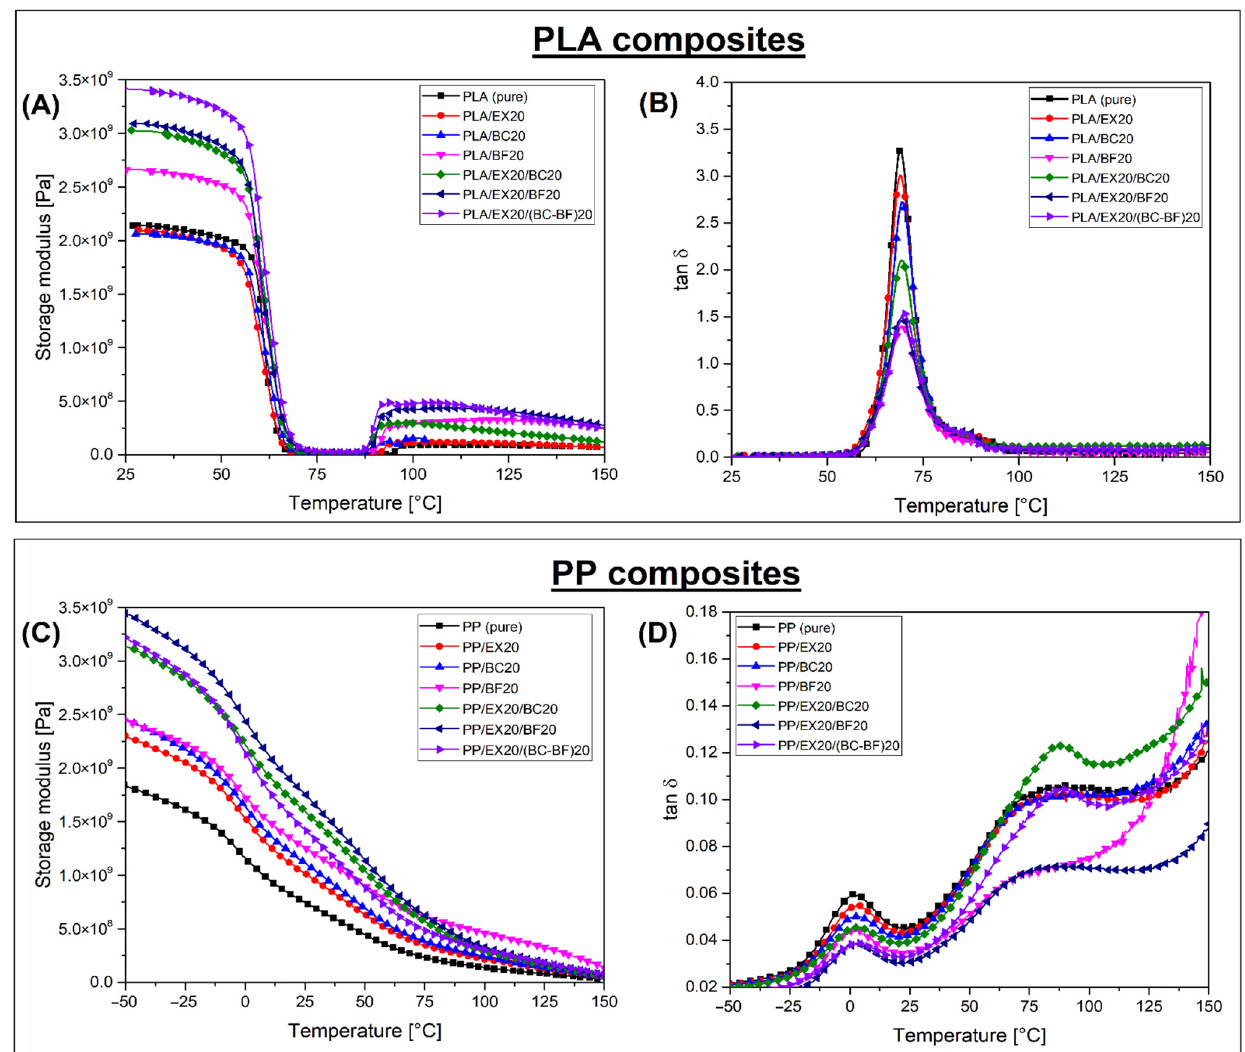
Figure 8. The results of the DMTA analysis of ( A , B ) PLA -based and ( C , D ) PP-based composites. The plots collect the results of the storage modulus and tan δ measurements.